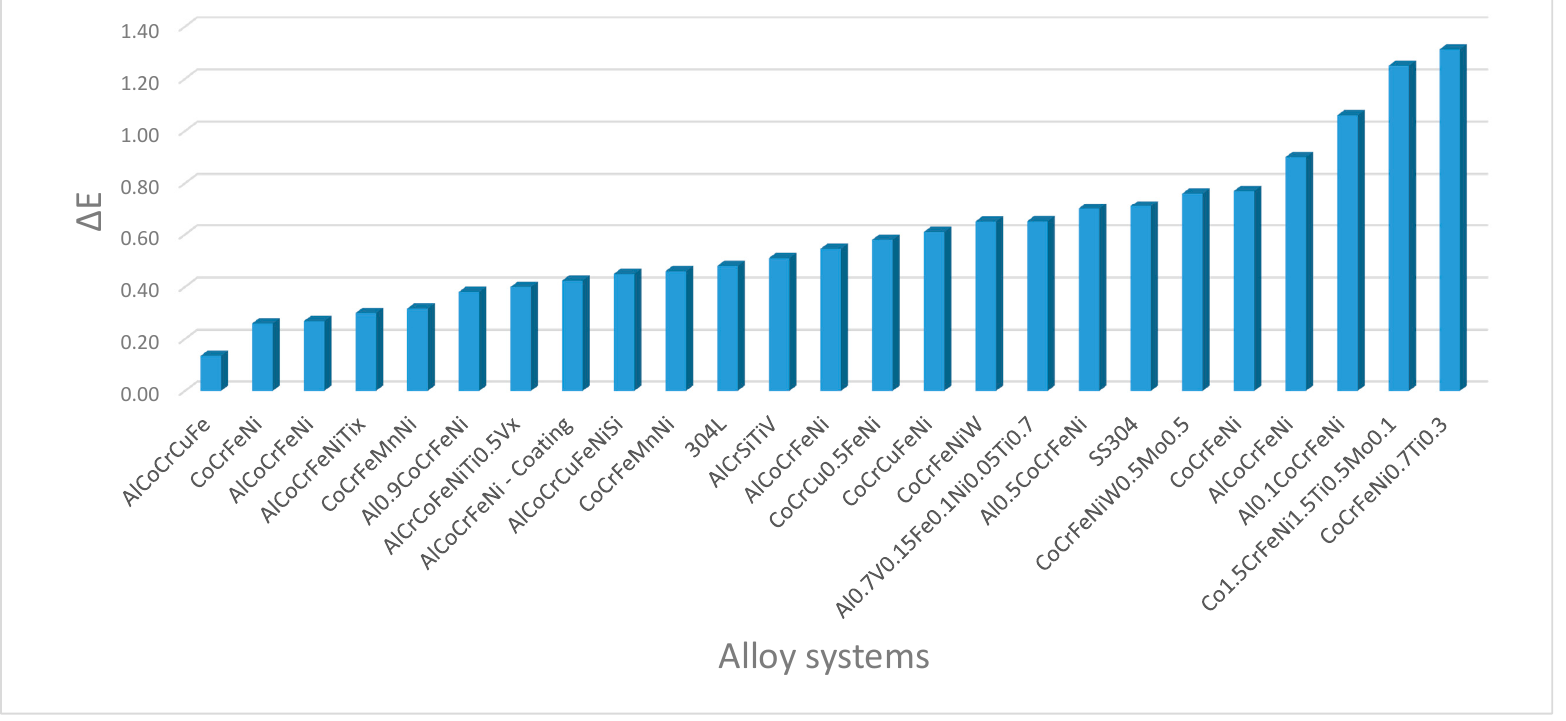
Figure 18. Pitting resistance of CCAs/HEAs in 3.5 wt% NaCl solution. Pitting resistance is calculated as the difference of corrosion potential and breakdown potential [18,28,29,31,32,34,51,63–65].